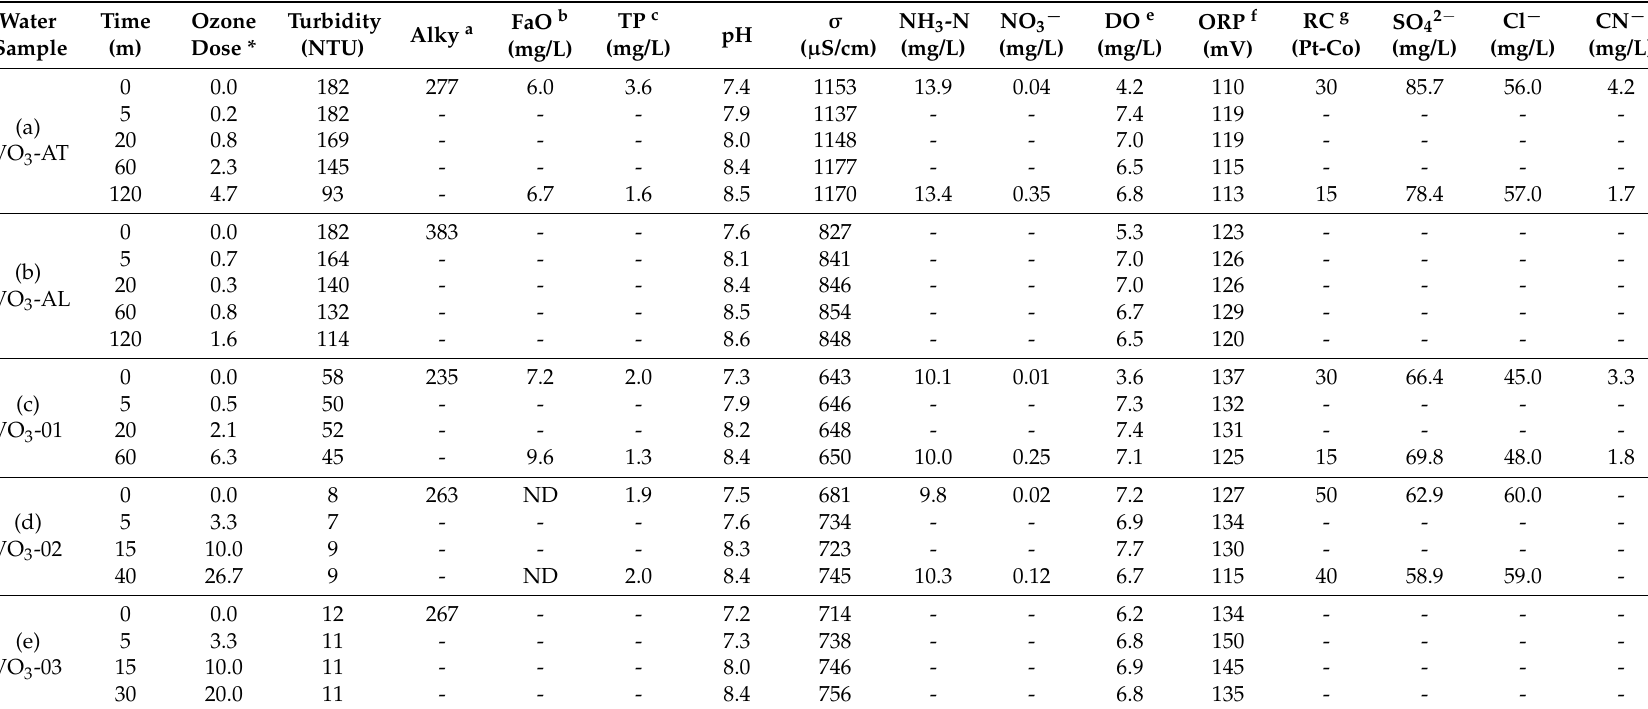
Table 2. Physicochemical characteristics of different water samples from the study area treated with different ozone (O 3 )